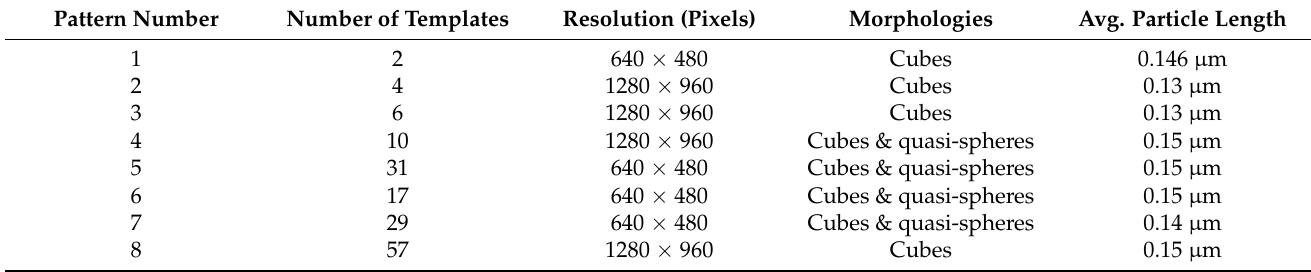
Table 1. A list of patterns used to create artificial images resembling SEM micrographs.